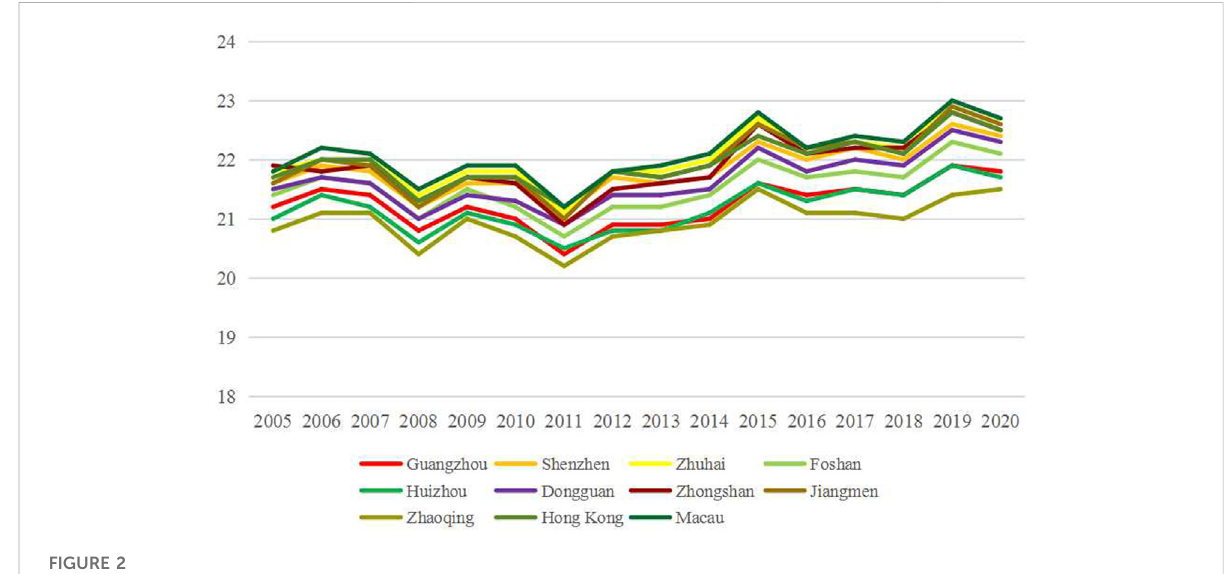
FIGURE 2 Temporal evolution diagram of the temperature-humidity index from 2005 to 2020.